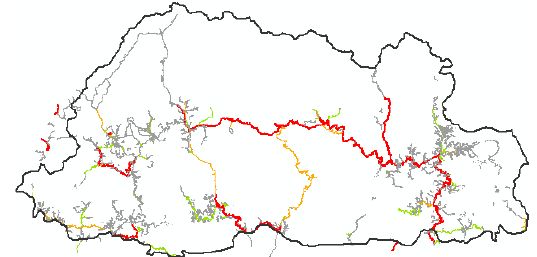
Figure 4. Traffic lines classification in